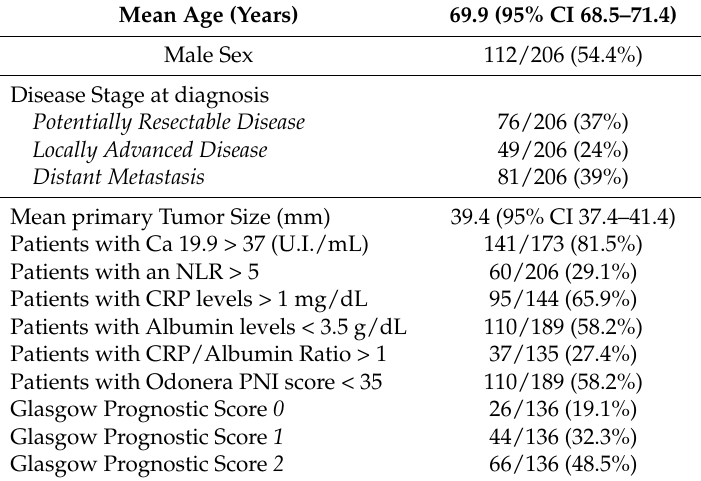
Table 1. General features and circulating inflammatory markers in the 206 evaluated pancreatic cancer